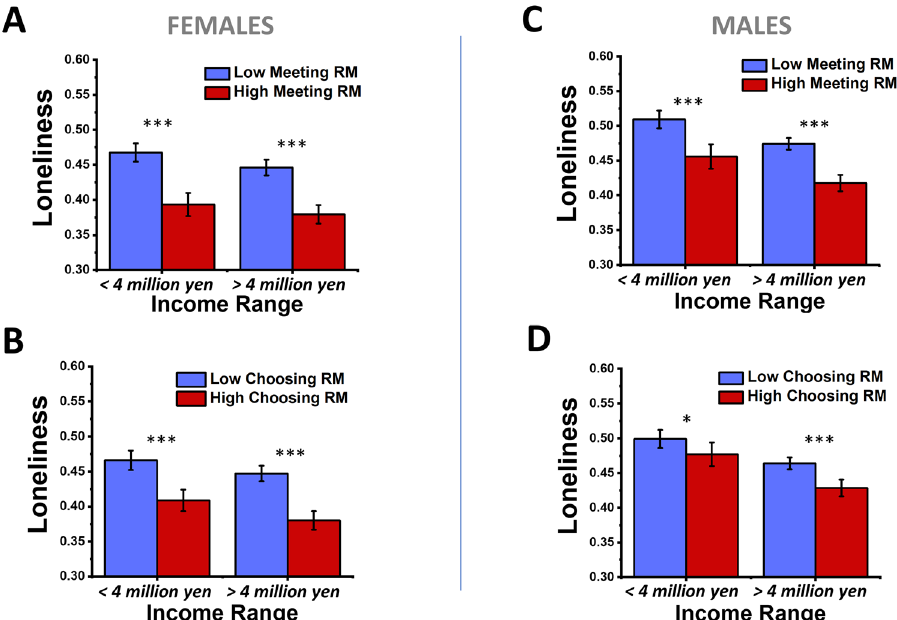
Figure 4. Plots of how perceptions of relational mobility and income associate in predicting loneliness for males and females. For females ( A , B ) versus males ( C , D ), and the meeting type of relational mobility ( A , C ) and choosing type of relational mobility ( B , D ), bar plots are presented showing the mean loneliness for major sub-populations of subjects that have either less than or higher than four million yen of annual household income, then further divided into subjects that have either lower (blue) or higher (red) perceptions of relational mobility than the average relational mobility value reported across the entire survey sample. Within each bar plot, for each of the income options, two-way ANOVA followed by Bonferroni-corrected pairwise tests were used to identify whether higher and lower relational mobility sub-groupings had significantly different means within each sub-population. For the pairwise tests within each income, labels were: * p < 0.05, ** p < 0.01, ***, p < 0.001. Loneliness scores are the continuous raw scores normalized by the max value of 30. Error bars are 95% confidence